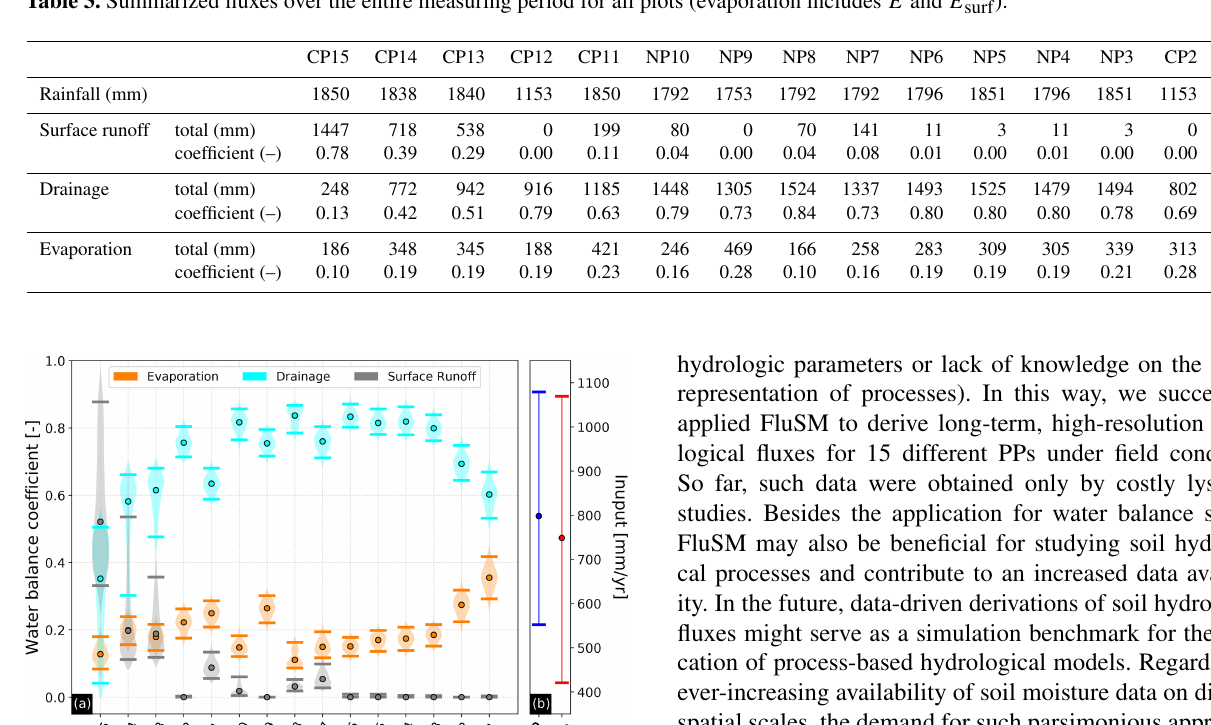
Table 3. Summarized fluxes over the entire measuring period for all plots (evaporation includes E and E surf ).